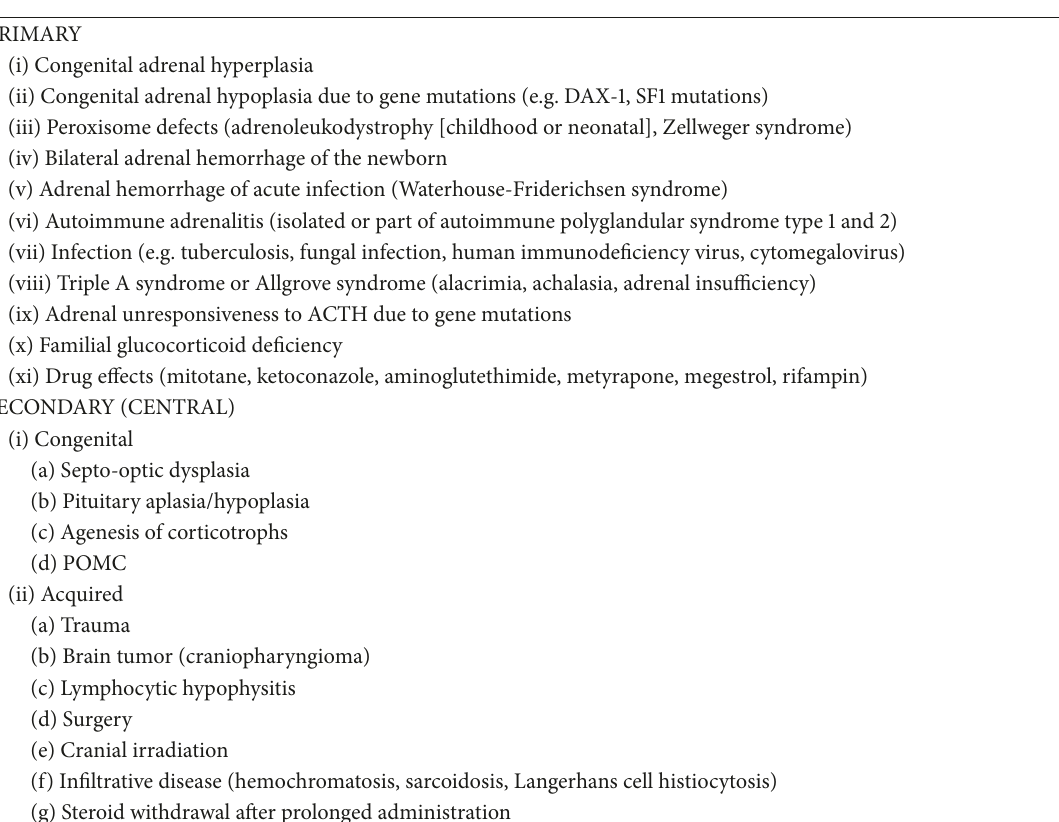
Table 1: Causes of adrenal